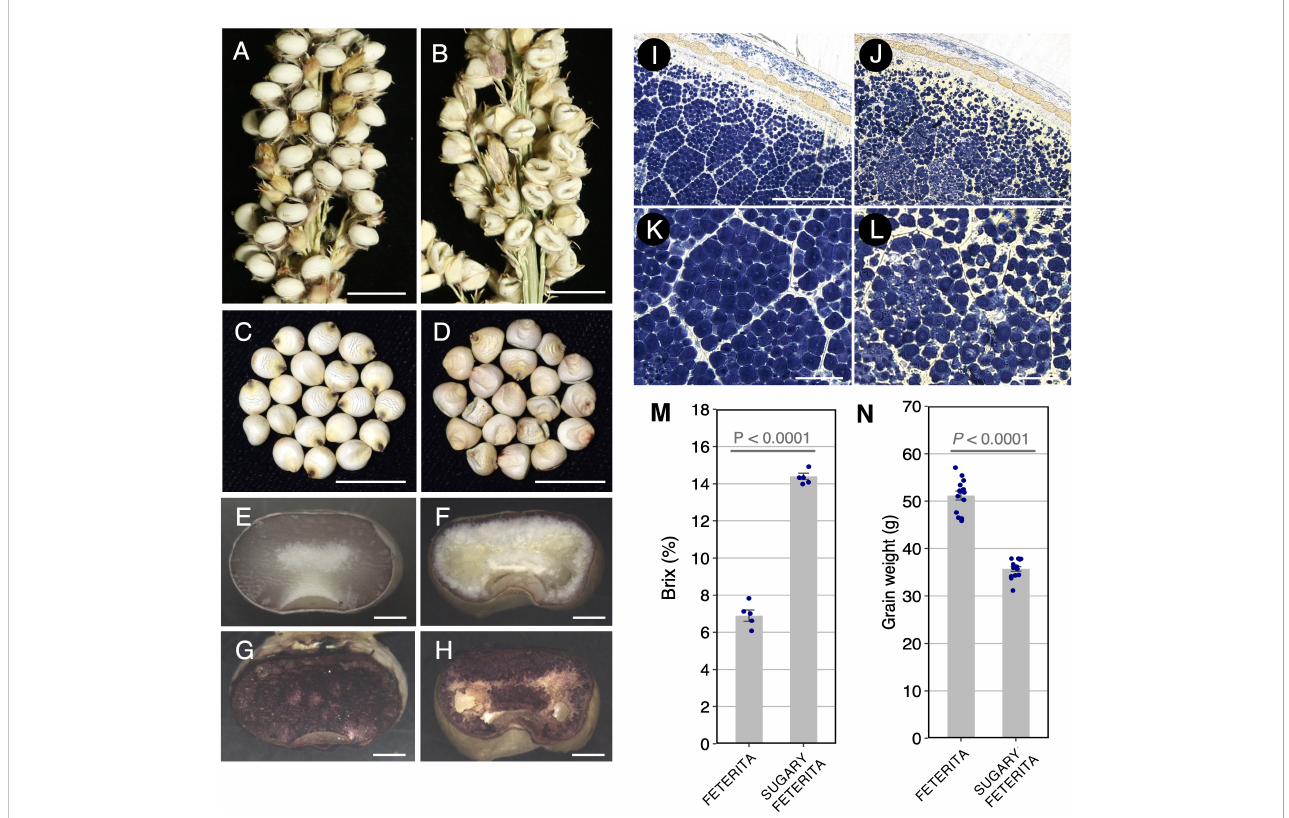
FIGURE 1 Seed phenotypes of the two varieties, ‘ FETERITA ’ (FET) and ‘ SUGARY FETERITA ’ (SUF). (A, D) Panicles of FET (A) and SUF (B) . Kernels of FET (normal, C ) and SUF (wrinkled, D ). E – G , Transverse sections of FET and SUF stained with iodine solution (G, H) . (K – N) , Cross sections of FET (I, K) and SUF (J, L) . Aberrant starch structures were observed in (L) . (M, N) Brix values (M) and grain weights (N) of the seeds. Scale bars: 1 cm in (A – D) , 1 mm in (E – H) , 200 m m in (I, J) , and 50 m m (K, L)